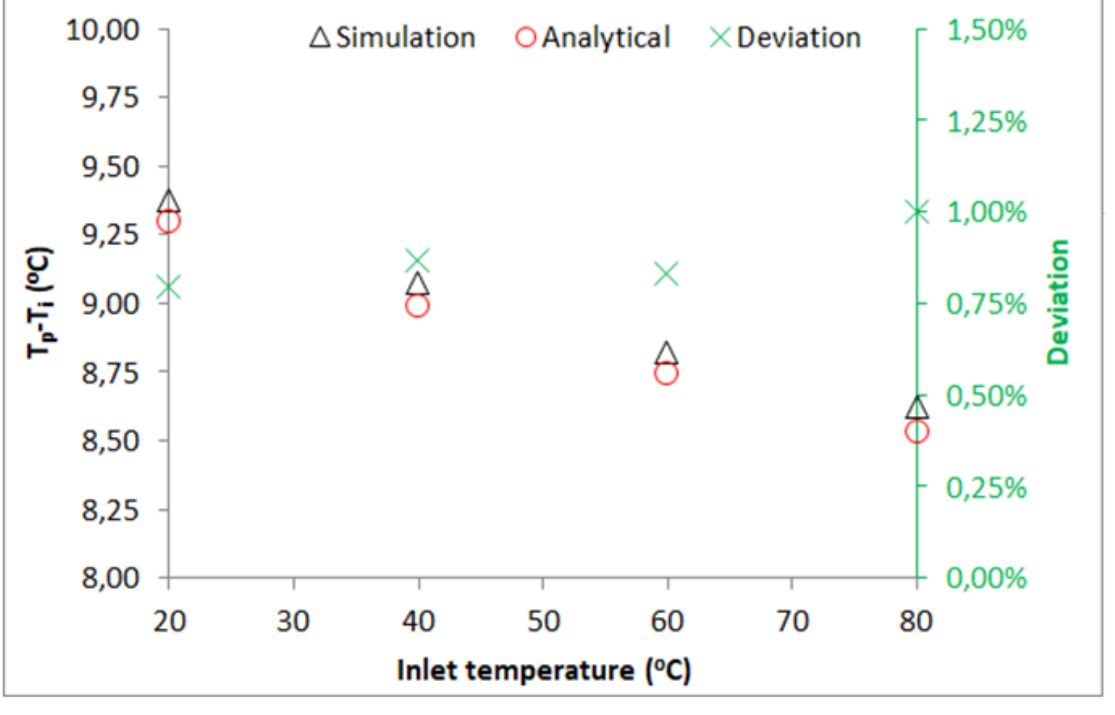
Figure 6. Verification regarding the temperature difference between the absorber and the fluid in the inlet.